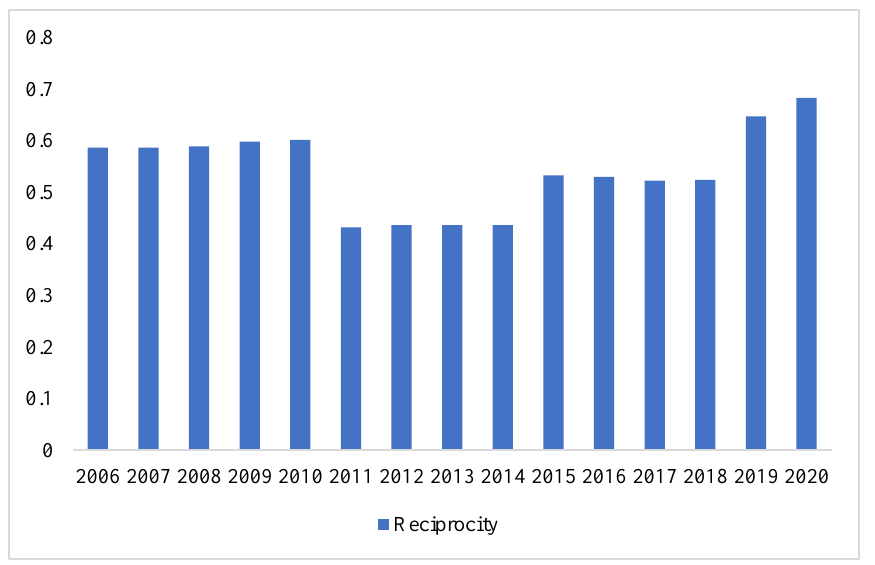
Figure 6. Reciprocity of the IGGE spatial correlation network, 2006–2020.